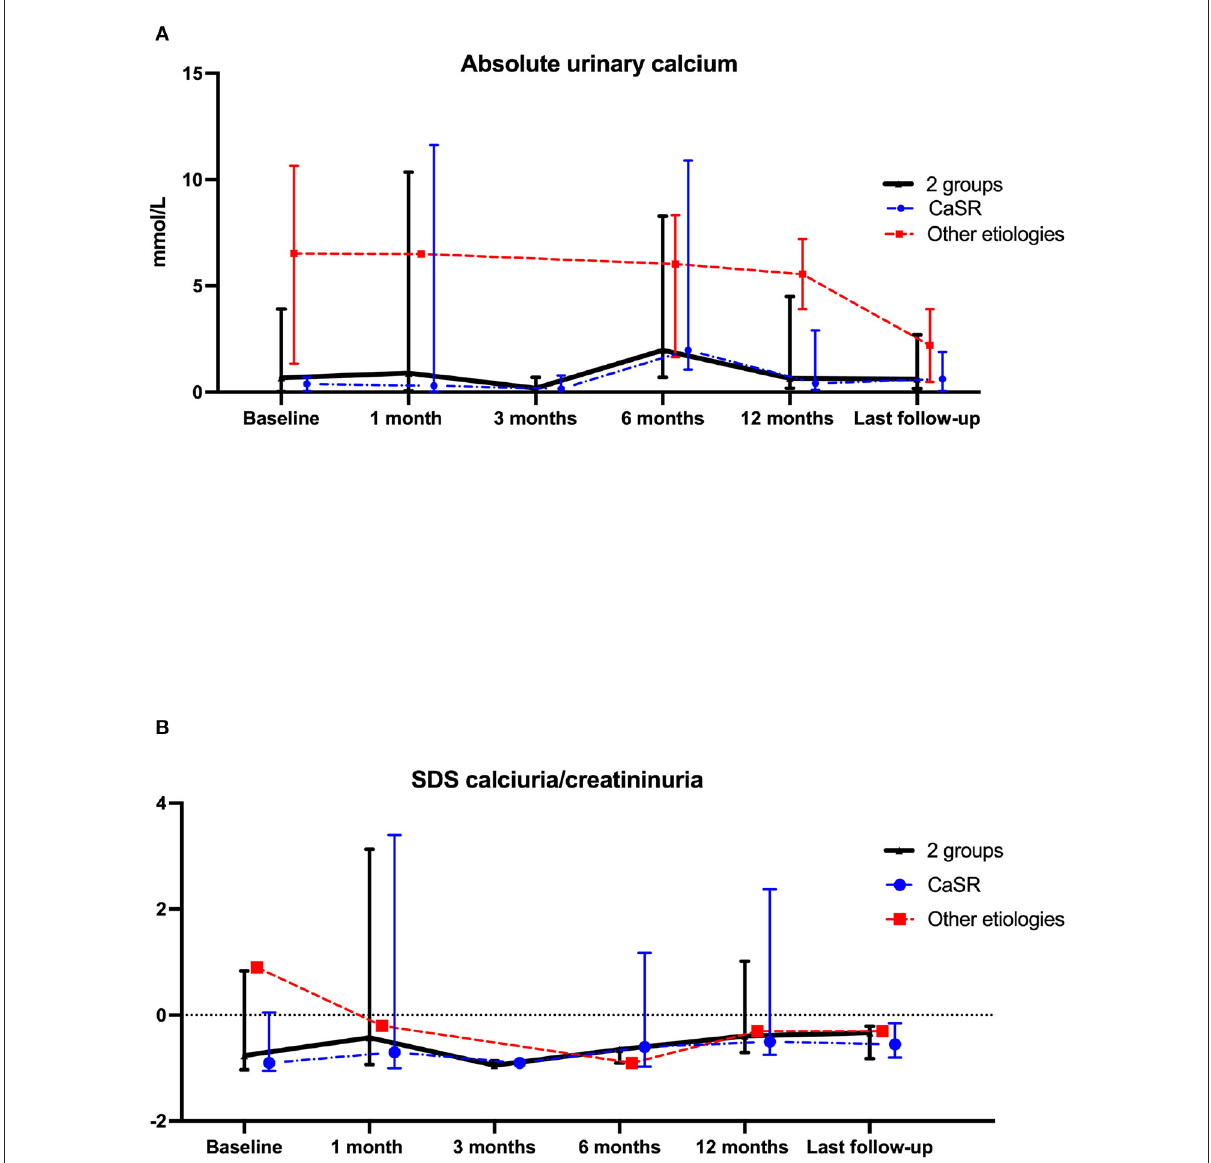
FIGURE2 Comparison of calciuria (A) and z-score for age calciuria/creatininuria on one urine sample (B) data at cinacalcet initiation and during follow-up. Each dot on the graph represents median with interquartile range of biological data at the different time-points. Statistical analyses were performed with Kruskall–Wallis test: p = not statistically significant (NS). The blue line represents the “ CASR mutation patients” sub-group, the red line represents the sub-group of patients without CASR mutation and the black line represents these 2